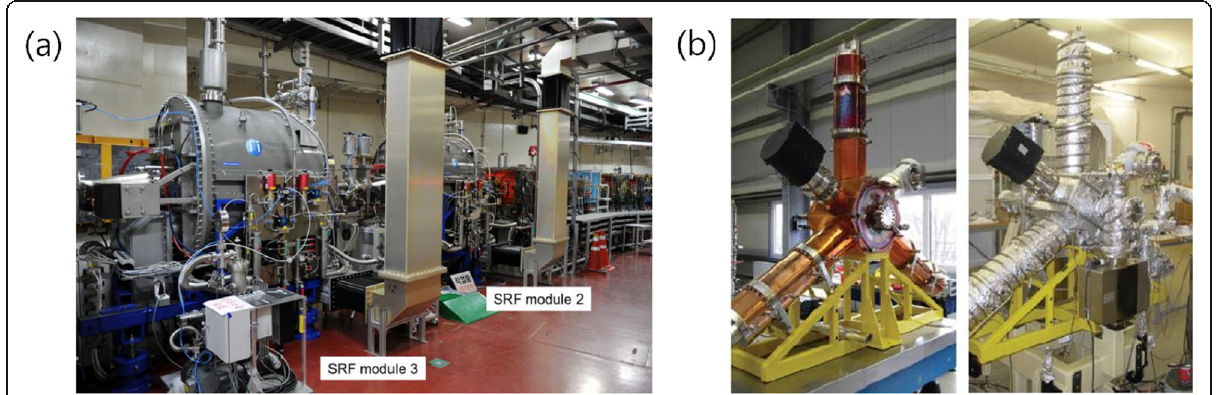
Fig. 5 RF system in storage ring. a Super-conducting cavity. b Normal cavity